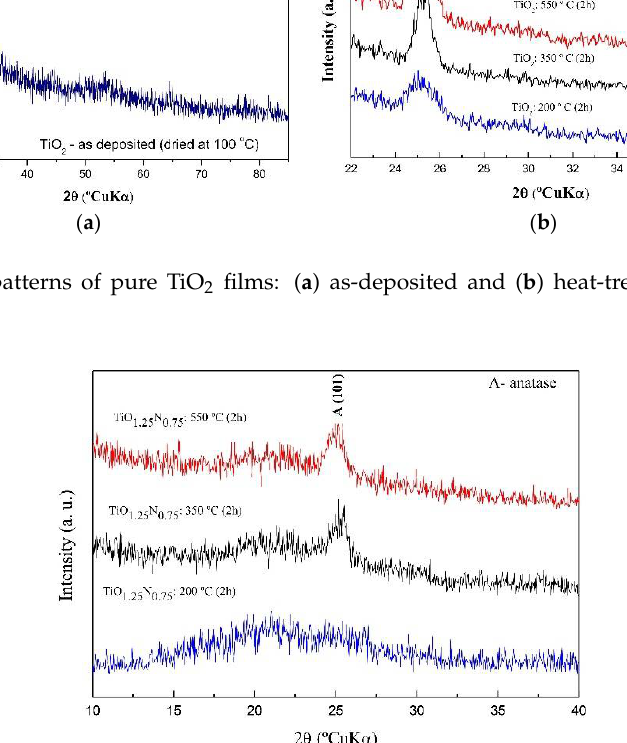
Figure 7. XRD patterns of TiO 0.25 N 0.75 films after heat treatments (from 200 °C up to 550 °C).